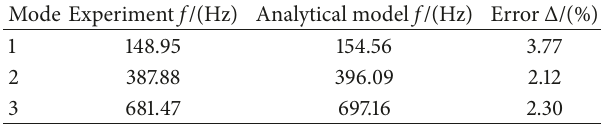
Figure 10: RV reducer dynamic testing setup.